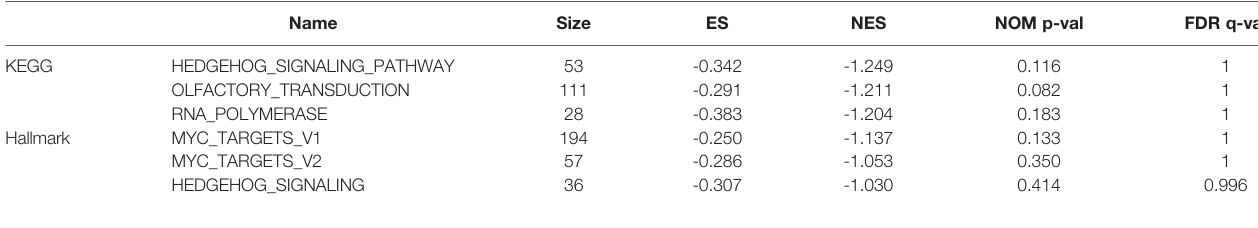
TABLE 6 | The top 10 Hallmark and KEGG pathway of